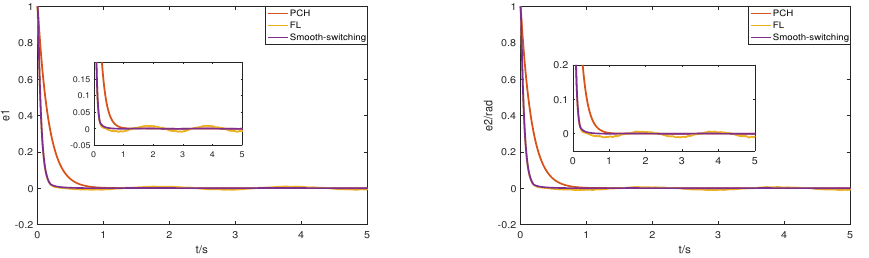
( a ) The error curve for joint 1. ( b ) The error curve for joint 2.